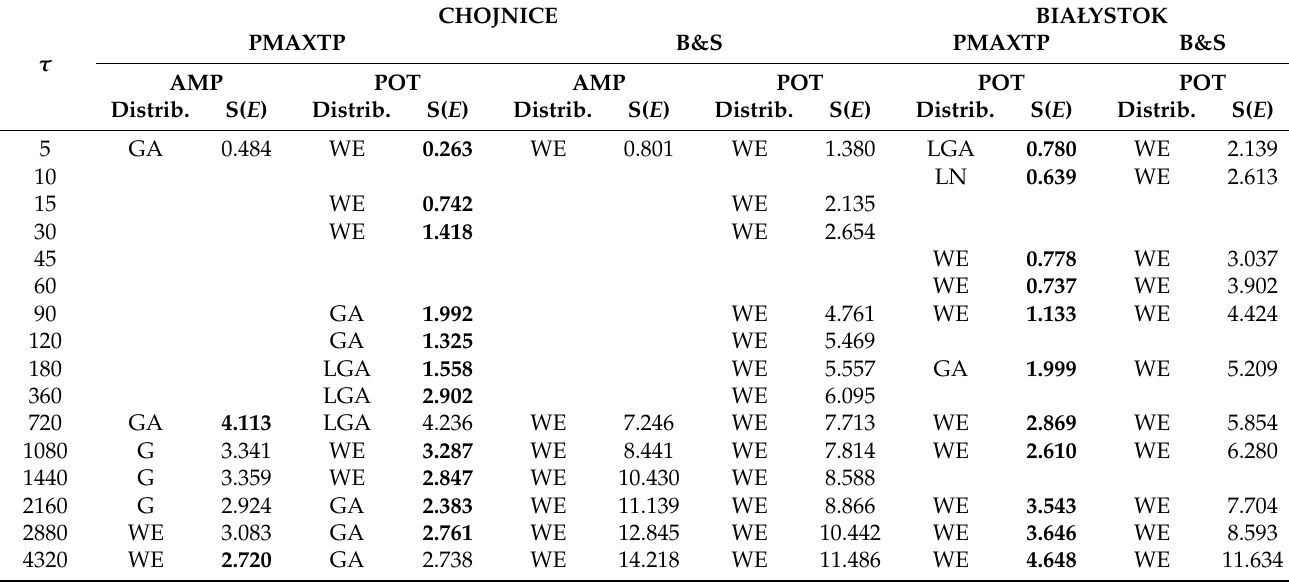
Table 9. Comparison of the PMAXTP and Bogdanowicz-Stach ý methods for P AMP τ and P POT τ , where τ = {5, 10, 15, 30, 45, 60, 90, 120, 180, 360, 720, 1080, 1440, 2160, 2880, 4320} (min), using the standard error of fit S( E ). The comparison refers to the maximum precipitation values computed for the meteorological station in Chojnice ( P AMP τ and P POT τ ) and in Bialystok ( P POT τ ). Values in bold type are the smallest errors S( E ) obtained separately for the Chojnice and Bialystok